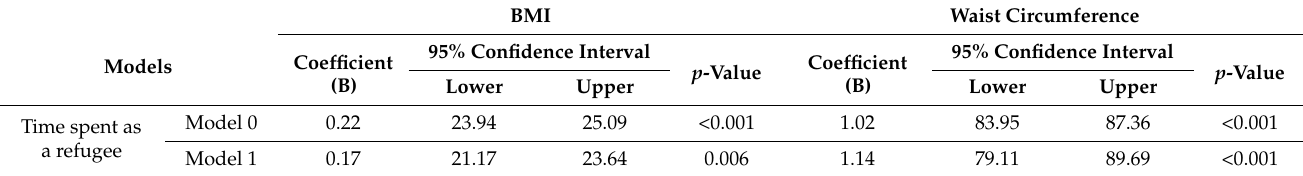
Table 6. The relationship between time spent as a refugee, BMI, and waist circumference.